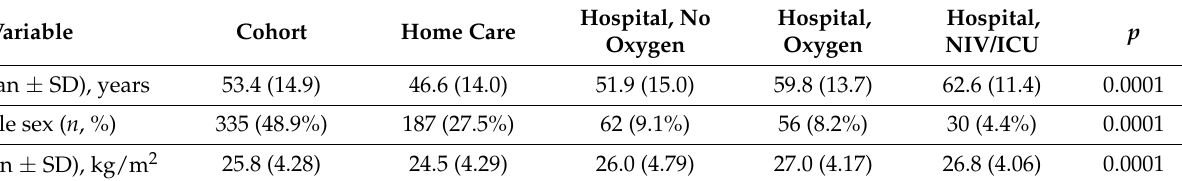
Table 1. Baseline characteristics of the